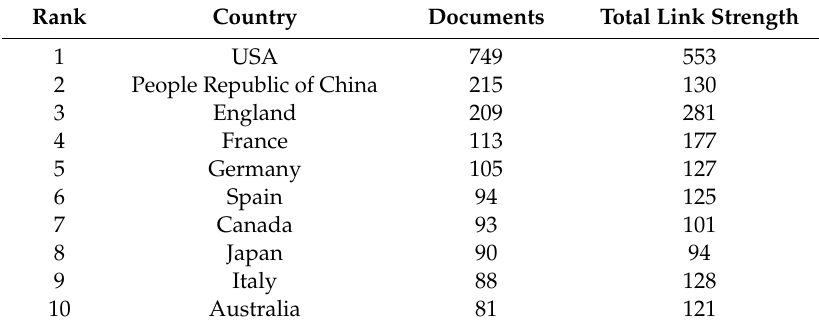
Table 2. The top 10 collaborative countries / regions in the field of the prediction of infectious diseases. Rank Country Documents Total Link Strength 1